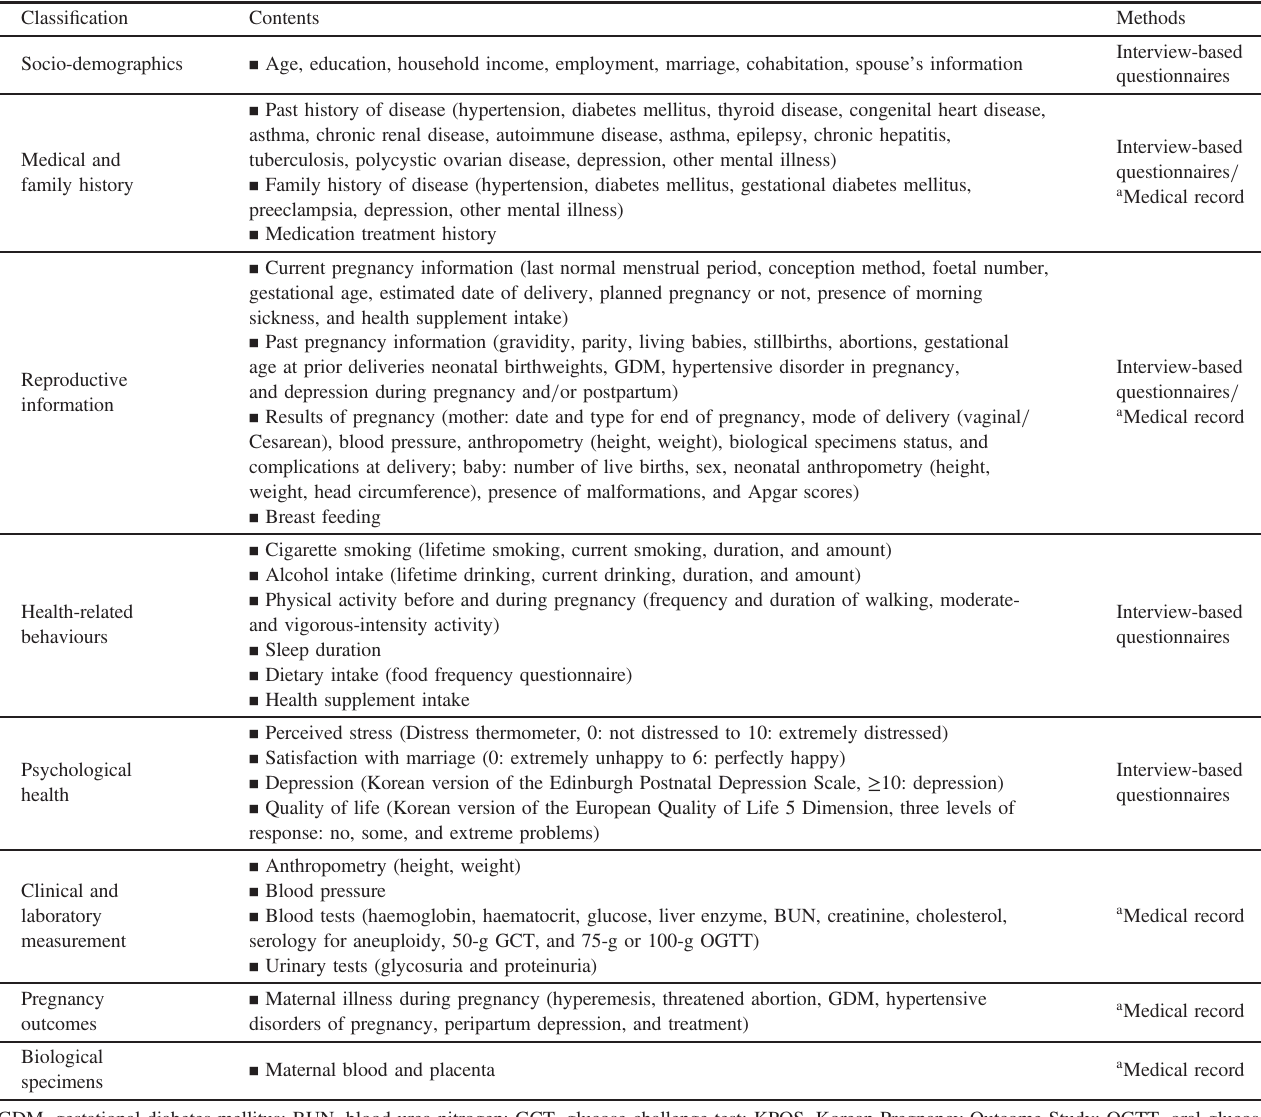
Table 2. Details of data and material collection in KPOS